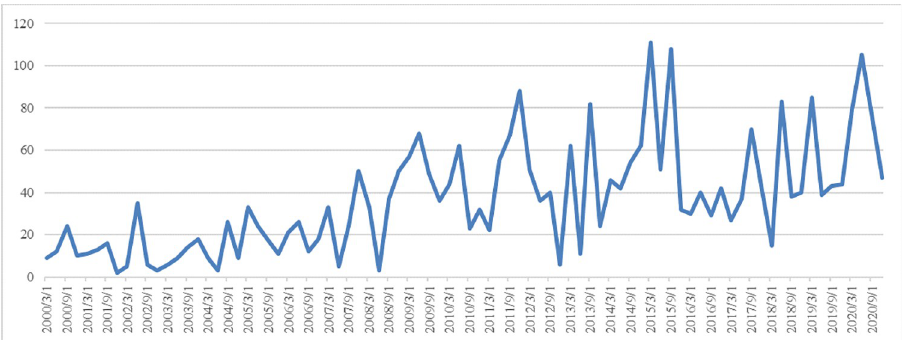
Fig 2. Trend of SME fiscal and financial policy